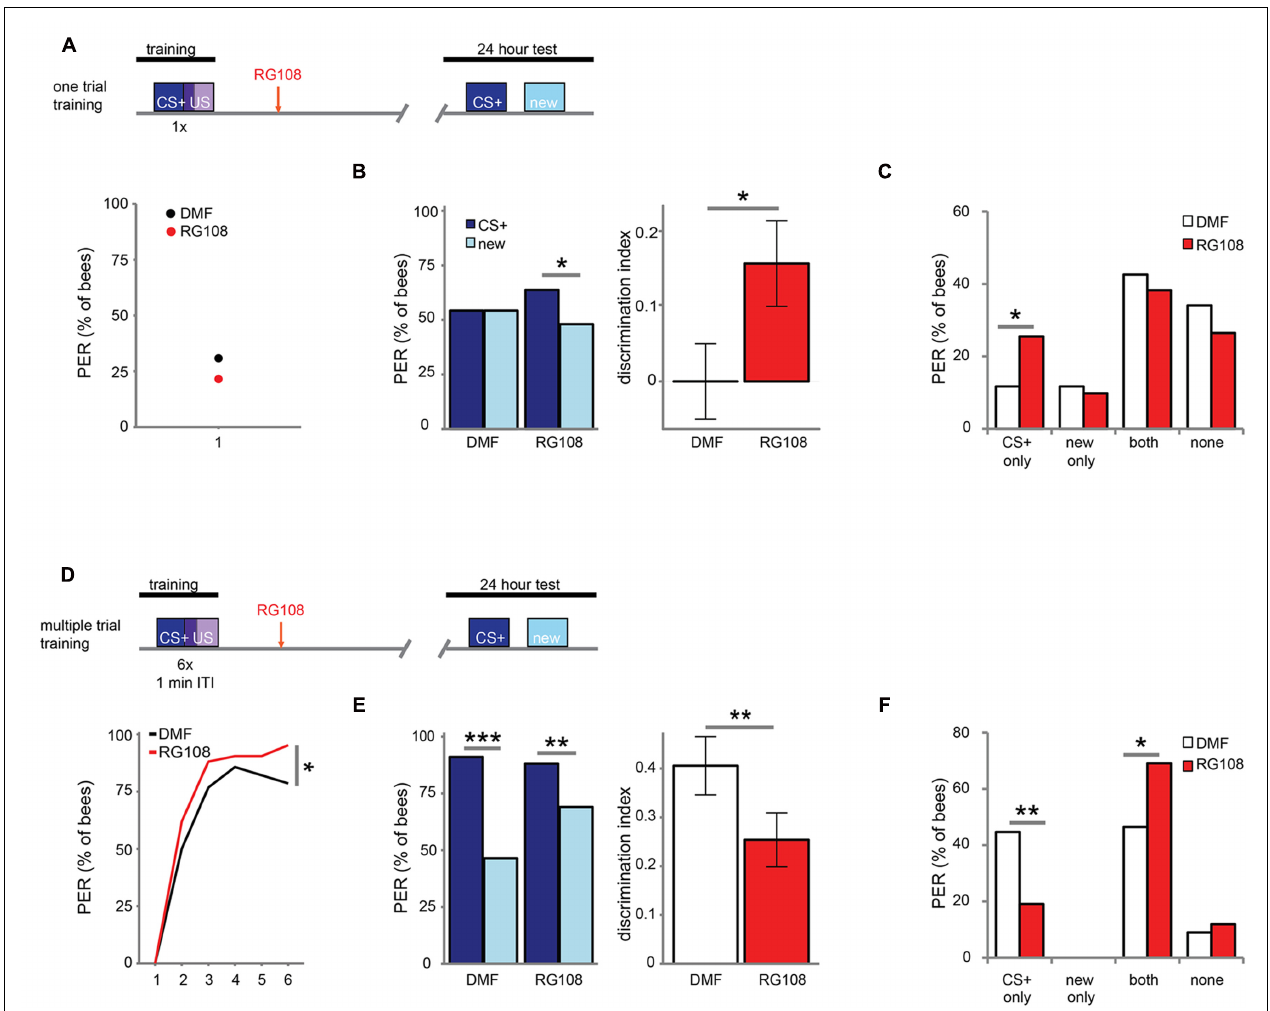
FIGURE 2 | DNA methyltransferases influence stimulus-specific memory bidirectionally. (A) Bees were trained with one CS-US pairing (D) or six CS-US pairings with an inter-trial interval (ITI) of 1 min. Two hours after the training bees were treated with the Dnmt inhibitor RG108 or the solvent DMF (dimethylformamide) and tested for memory retention (CS + response) and generalization (new response) after 24 h. (B) Solvent treated bees did not show stimulus-specific memory in the 24 h test following one CS-US pairing, but bees were able to discriminate between the CS + and new odor after Dnmt inhibition [ n (DMF) = 94, n (RG108) = 102]. (C) Bees were sorted into responding groups: bees responded more often only to the CS + after Dnmt inhibition. (D) Bees were trained with six CS-US pairings. The group later treated with RG108 had a slightly better performance. (E) Bees’ stimulus-specific memory was impaired in RG108 treated bees after multiple trial training [ n (DMF) = 56, n (RG108) = 42]. (F) Treated bees responded less to the CS + only and more often to both odors. Note that the better performance of this group of bees (shown in D ) would by its own lead to the opposite effect, thus making the effect of RG108 stronger. ∗ p -value < 0.05; ∗∗ p -value < 0.01; ∗∗∗ p -value <